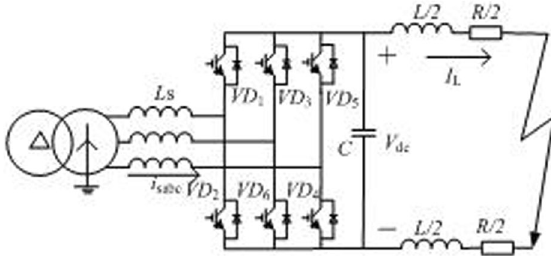
Fig. 3 System diagram for pole-to-pole faults